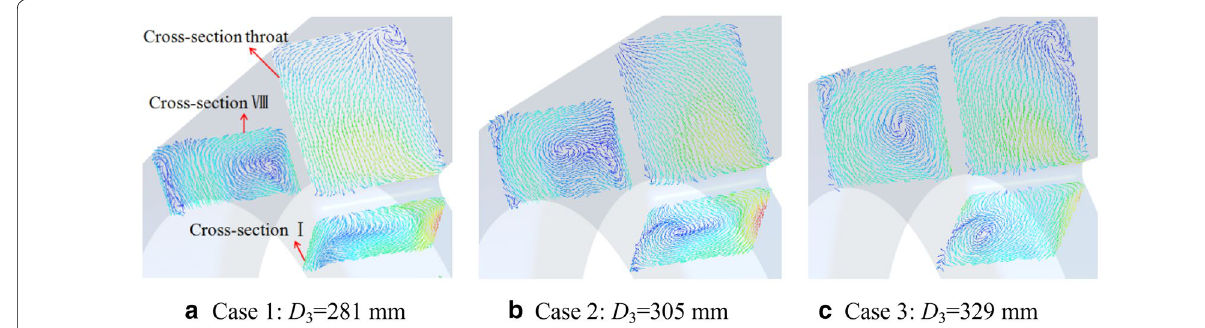
Figure 11 Tangential components of velocity at cross-sections at flow rate of 30 m 3 /h